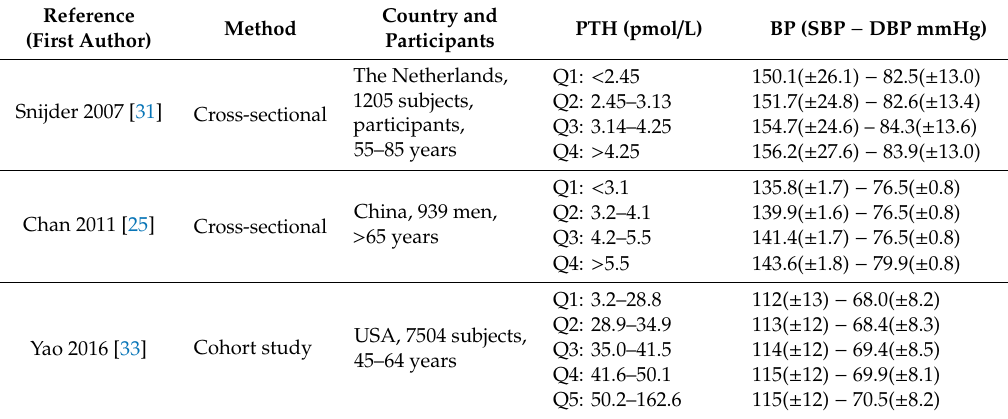
Table 2. Blood pressure (BP) values by quartiles or quintiles of parathyroid hormone (PTH) levels in human studies.